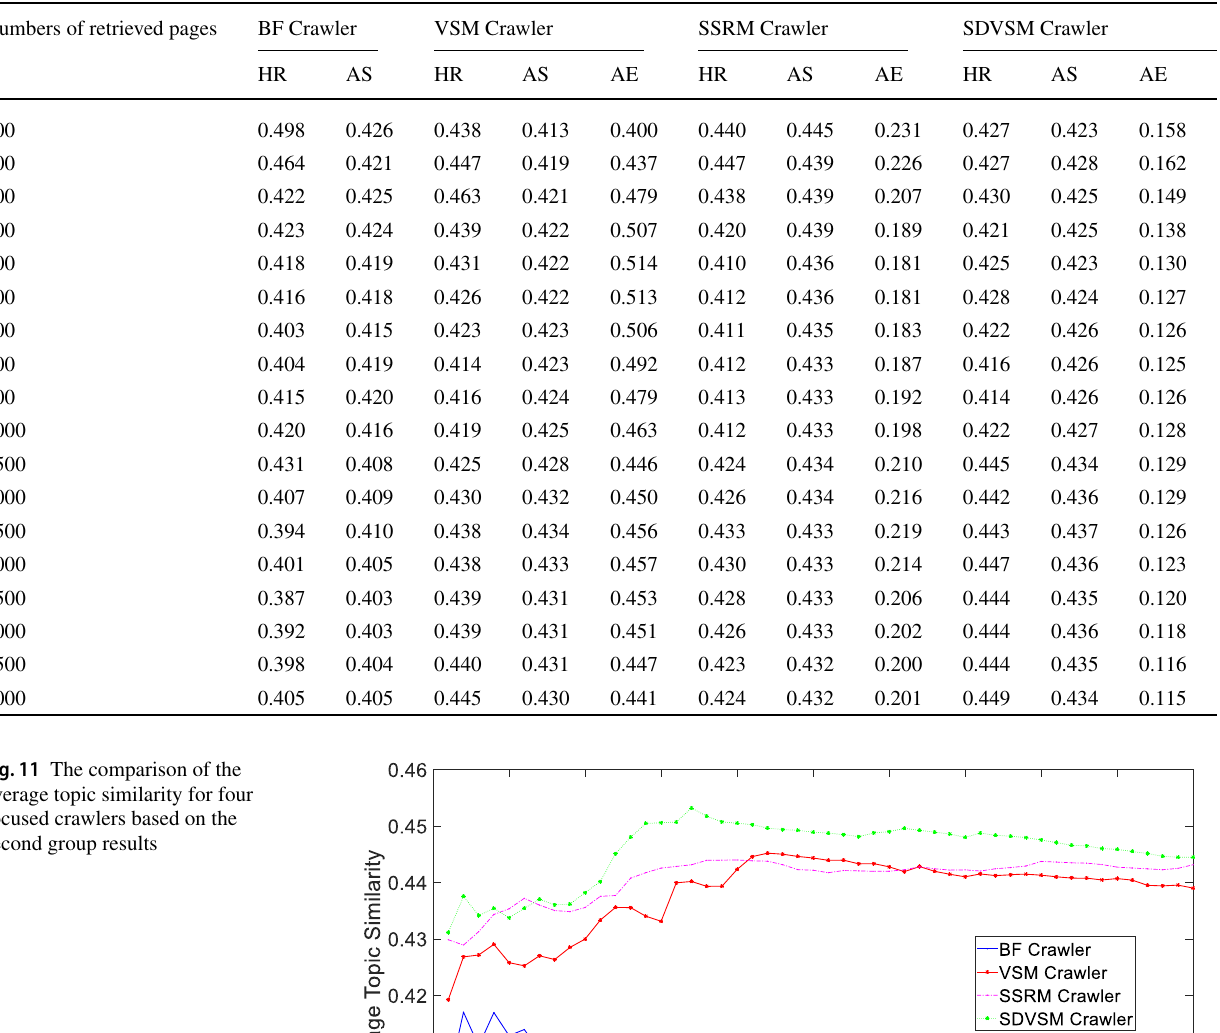
Table 6 The third group results including HR, AS and AE for four focused crawlers